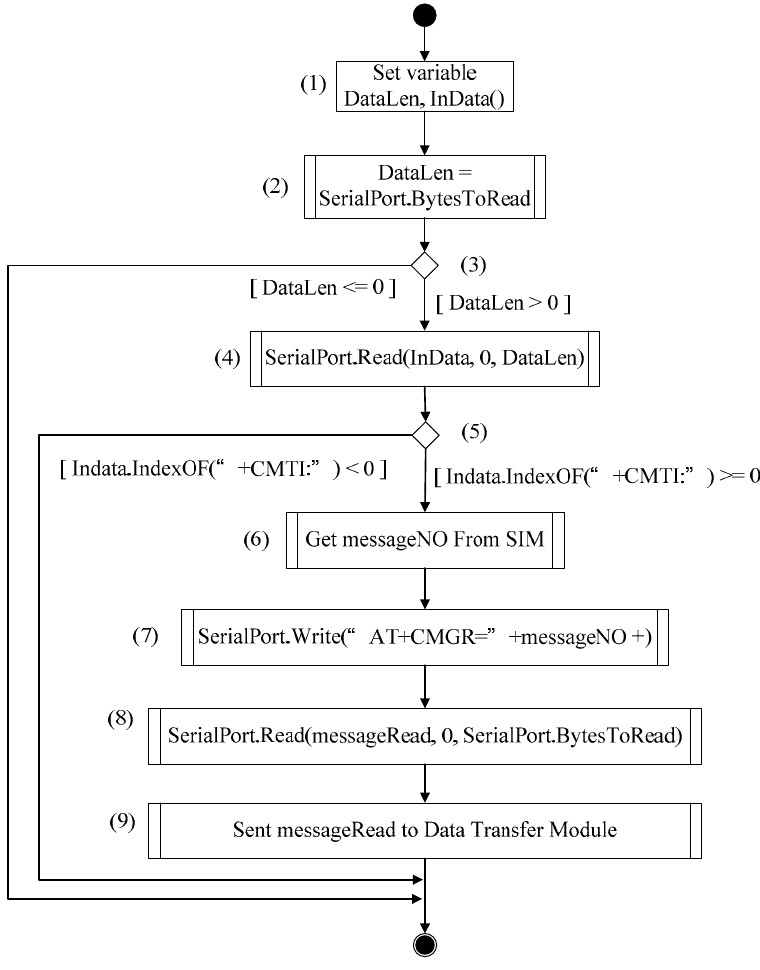
Figure 7. The ‘receive’ process in GSM/SMS communication.